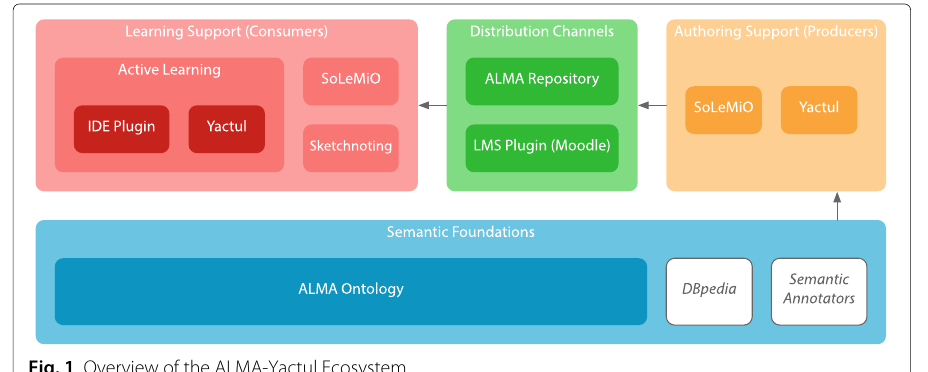
Fig. 1 Overview of the ALMA-Yactul